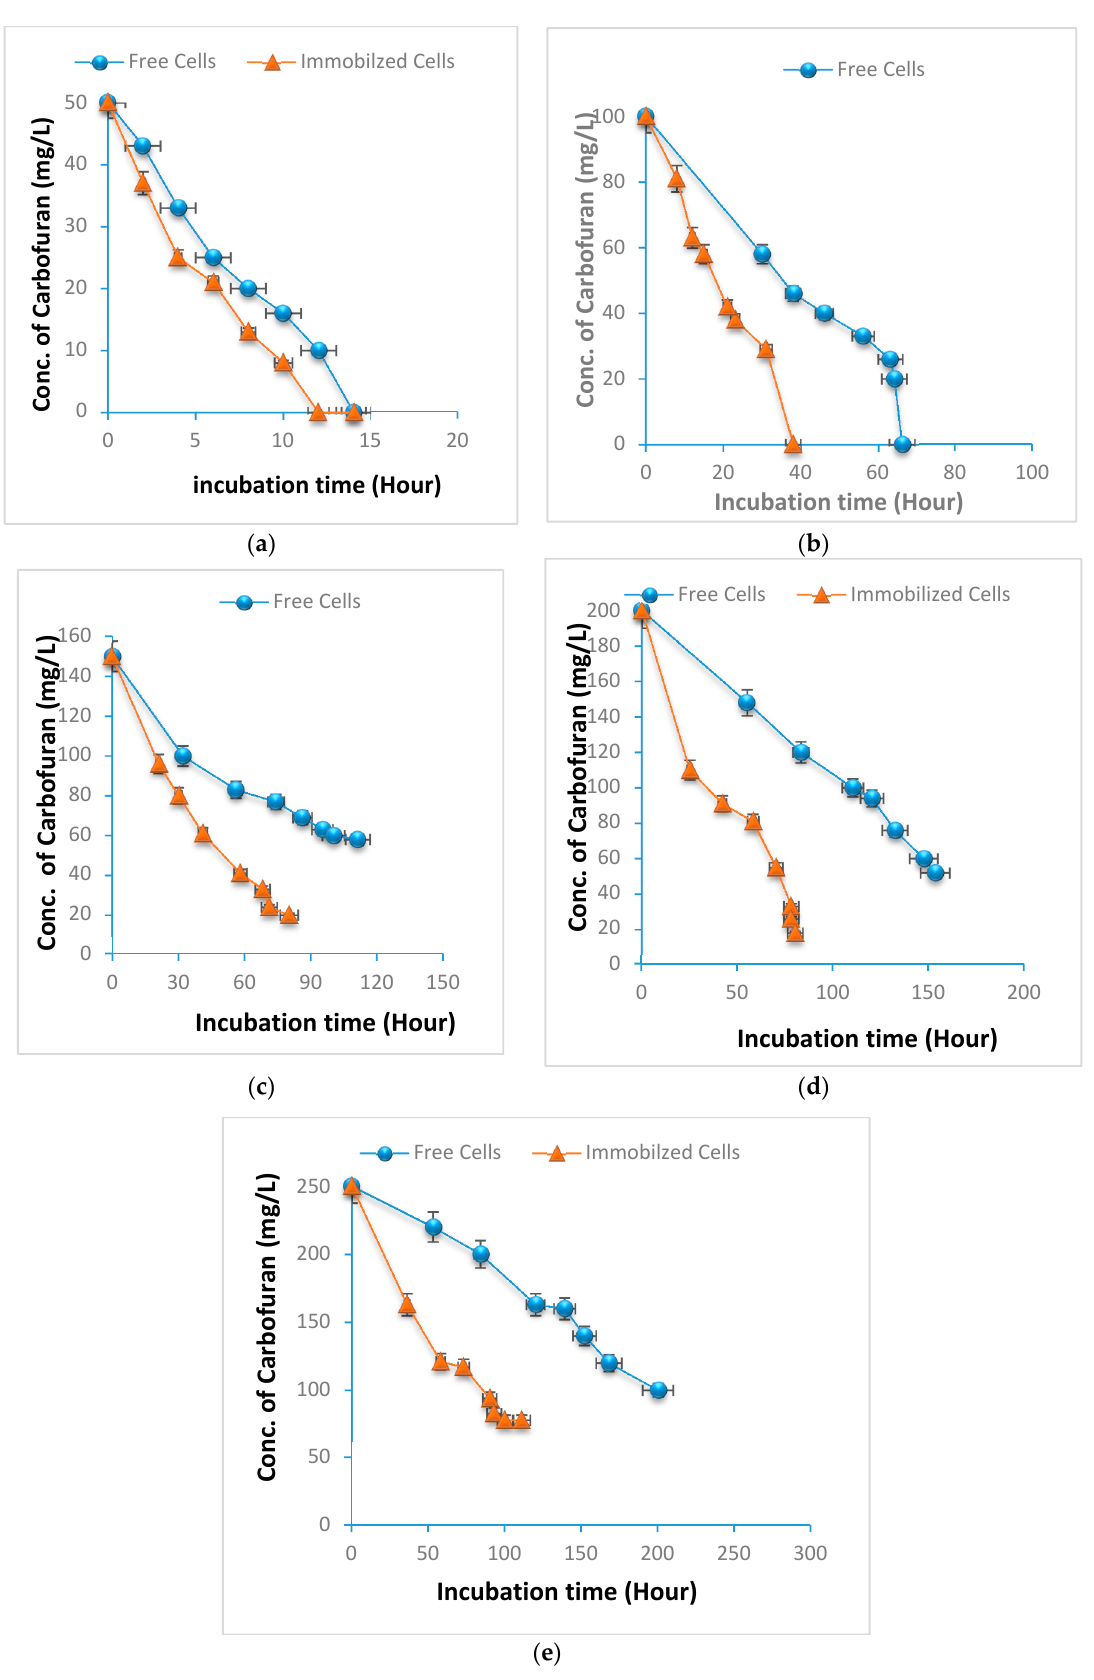
Figure 1. Effect of different concentrations of carbofuran on free and immobilized Enterobacter sp. cells on the degradation of carbofuran over a long period of incubation. The concentrations of carbofuran selected were ( a ) 50 mg/L, ( b ) 100 mg/L, ( c ) 150 mg/L, ( d ) 200 mg/L, and ( e ) 250 mg/L. Data represent mean ± SD, n = 3.